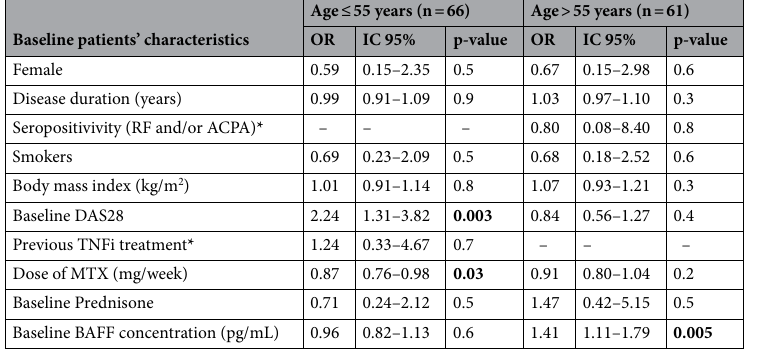
Table 2. Association between patients’ characteristics and the development of ADA at 6 m (univariable analysis), stratified by age. The univariable logistic regression analysis included 127 patients. Odds ratio (OR) and 95% confidence interval (CI) were calculated. Significant statistical differences are noted in bold. p-value < 0.05 was considered statistically significant. RF rheumatoid factor, ACPA anti-citrullinated